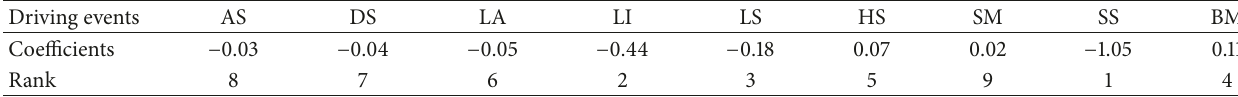
Table 5: Influence on score when driving event occurs once (every 50